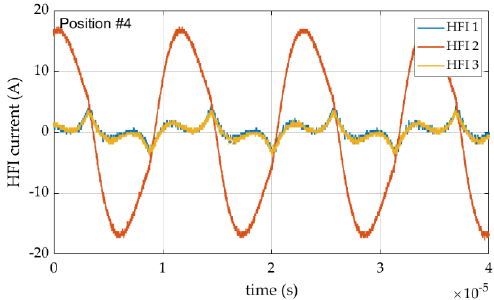
Figure 20. HFIs output currents with full coupling with the second track coil (Position #4).